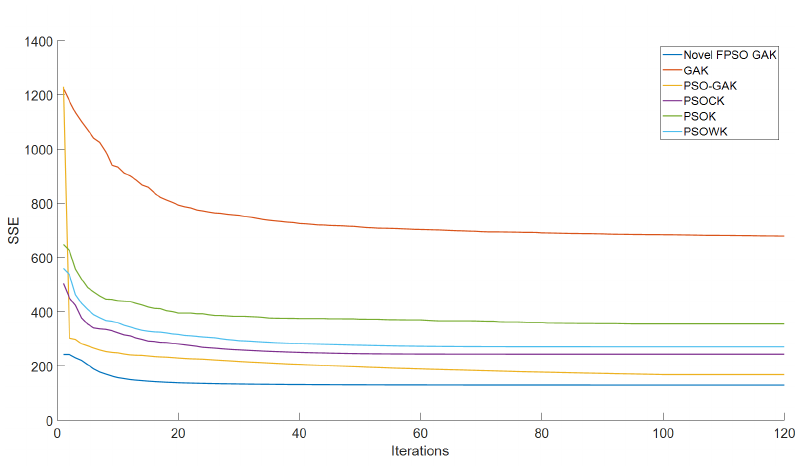
Figure 6. The SSE convergence curve for the searching optimal initial clustering centers stage of taxi GPS dataset from Chongqing (China).